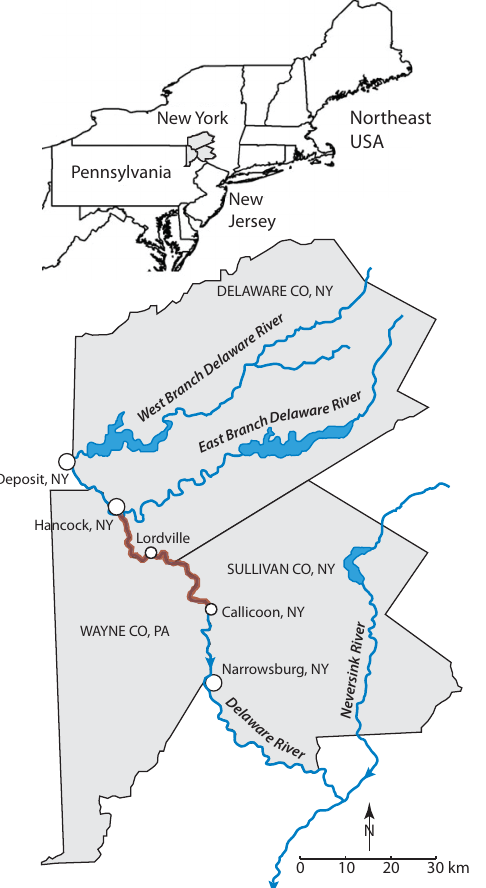
Figure 1. Delaware River reach (highlighted) on the border between New York and Pennsylvania between Hancock and Callicoon.